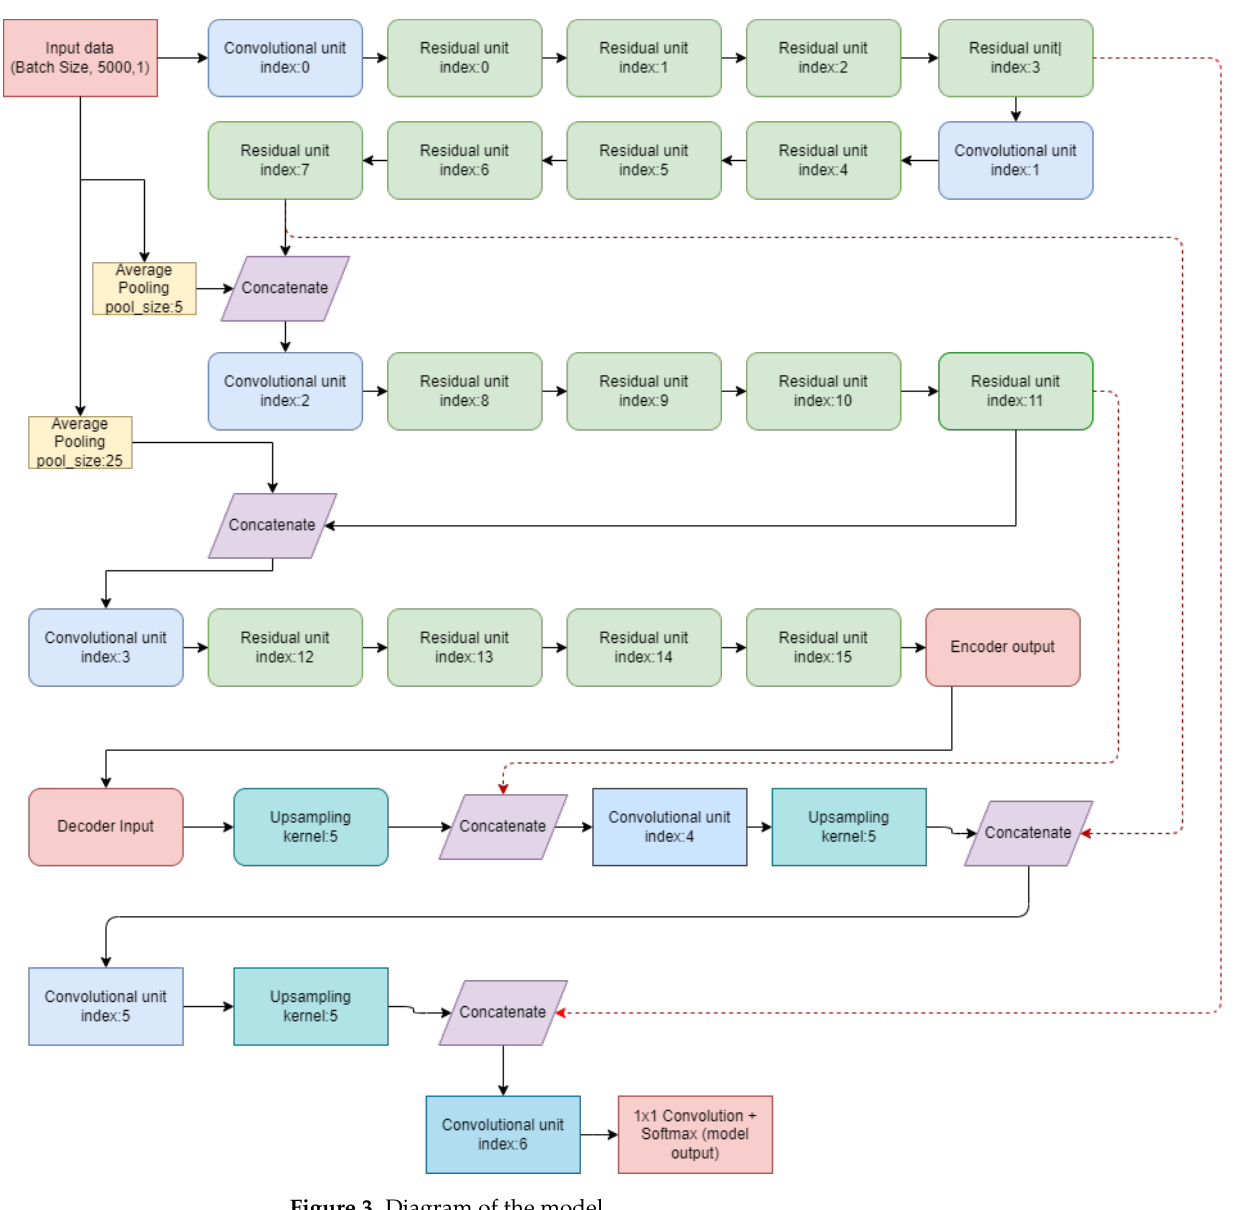
Figure 3. Diagram of the